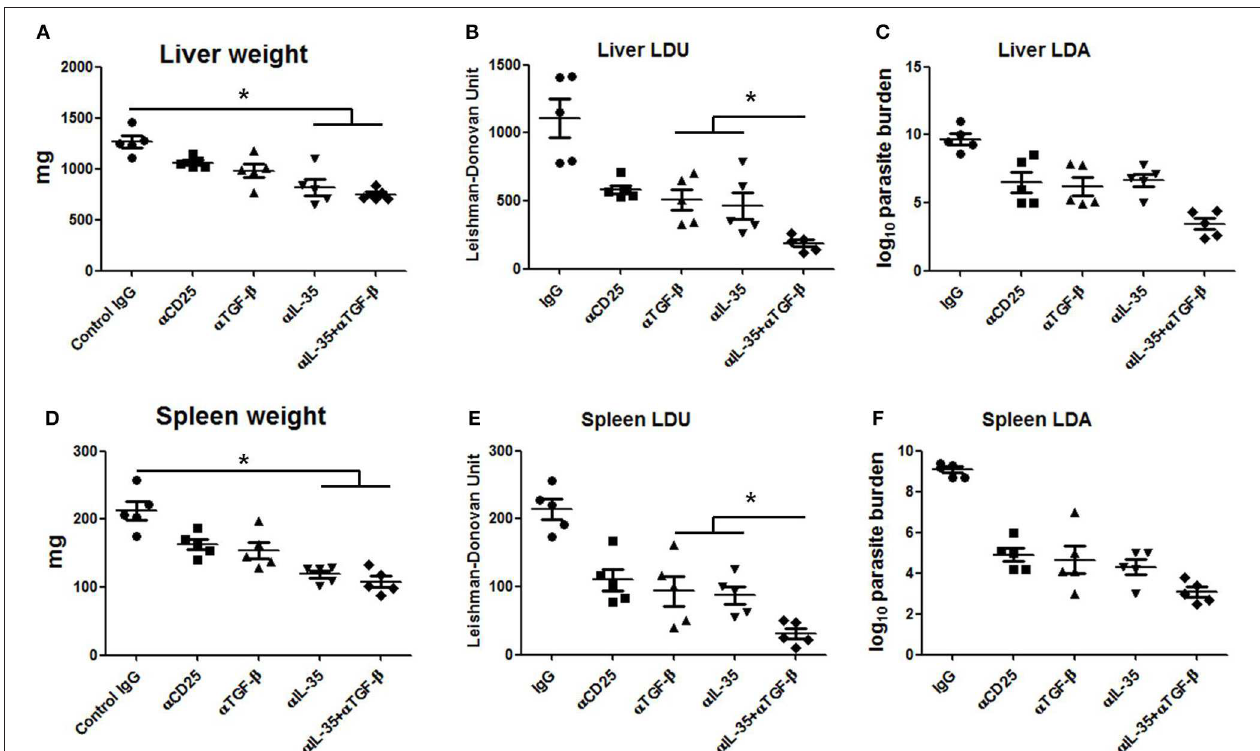
FIGURE 7 | Parasite burden in neutralizing antibody treated infected mice. Infected BALB/c mice injected with 200 µ g of neutralizing antibodies against TGF- β , IL-35, CD25, and isotype control (IgG cocktail) into the peritoneal cavity (as described in Materials and Methods) were sacrificed after 3 months of infection for measuring parasite burden in the liver and spleen. Total organ weights of liver and spleen (A,D) as well as their parasite burden were determined by LDU (B,E) and LDA (C,F) . Data expressed as means ± SE for five mice per group are representative of two independent experiments with similar results. * P < 0.05 as assessed by one-way ANOVA and Tukey’s multiple comparison